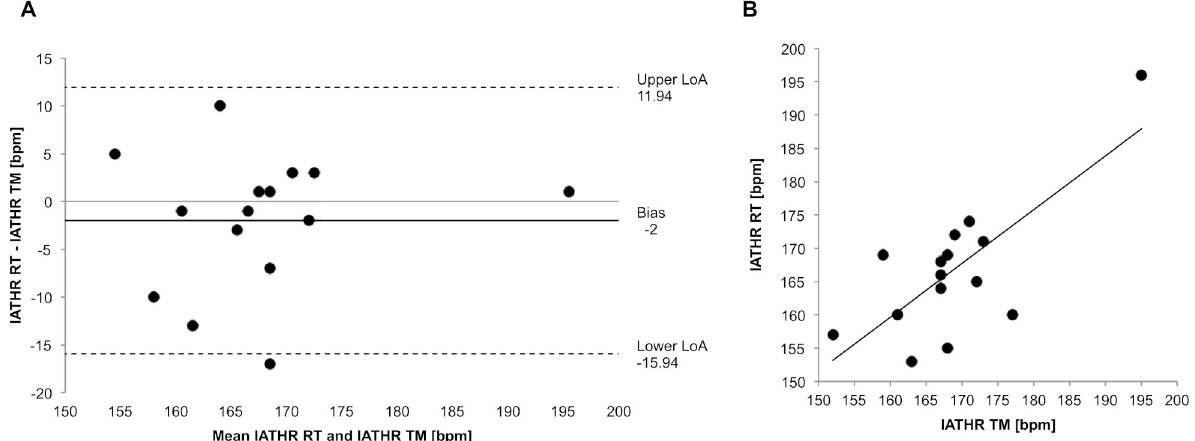
Fig 3. Agreement and strength of the relationship between TM and RT. (A) Bland-Altman plot to show the agreement of IAT HR and (B) Scatterplot of the IAT HR achieved for RT (y-axis) versus TM (x-axis) to show strength of relationship.